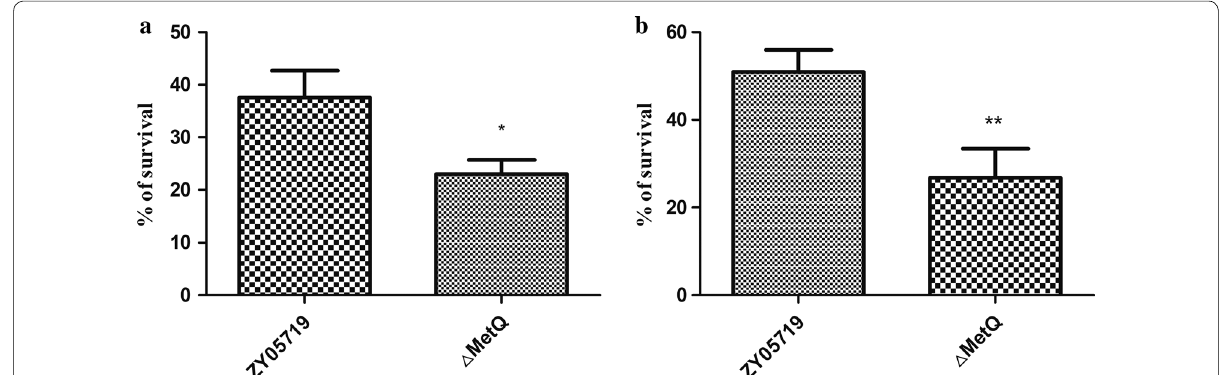
Fig. 1 Antiphagocytosis ability, intracellular survival ability and whole blood survival ability of △ MetQ . a Intracellular survival rate of △ MetQ and ZY05719 in RAW264.7 cells. b Survival rate of △ MetQ and ZY05719 in whole pig blood. The statistical significance was determined by Student’s t test. * p < 0.05; ** p < 0.01; *** p <